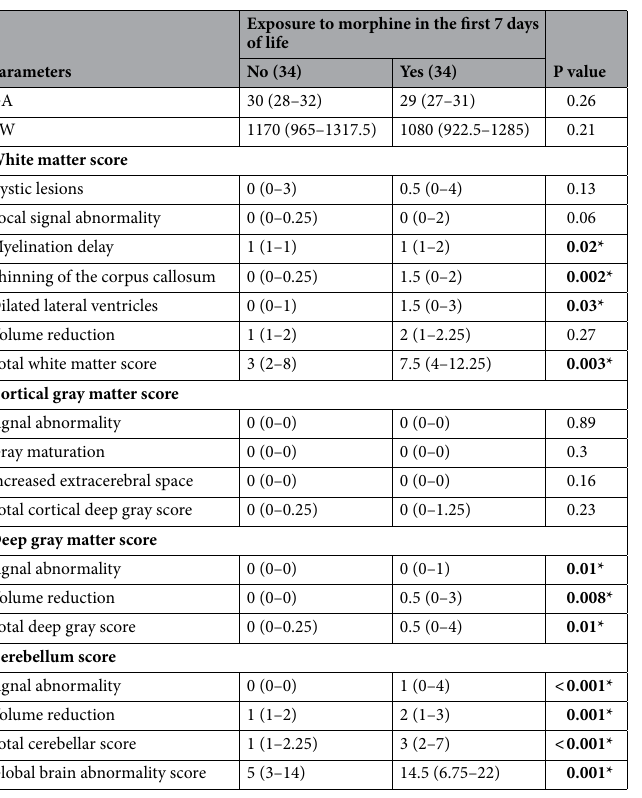
Table 4. Univariate analysis of global brain abnormalities score on TEA-MRI in relation to morphine exposure in first week of life after matching (n = 68). Data are presented as median (IQR), or number (%), as appropriate. Significant values are in bold. GA gestational age, BW birth weight. *Statistically significant at 5%